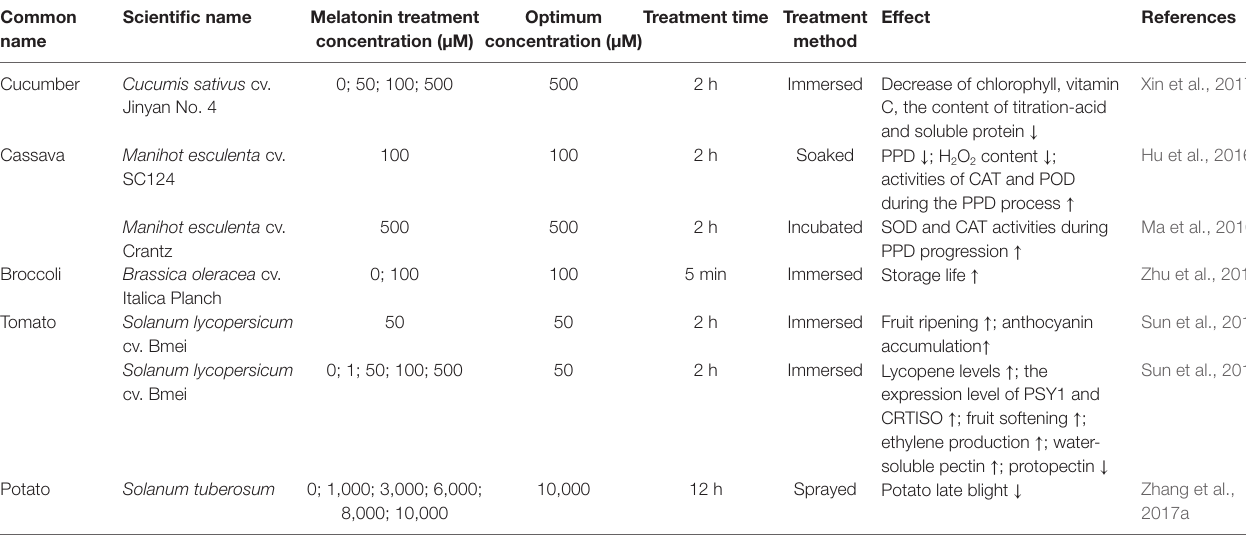
TABLe 4 | Effects of exogenous melatonin on the preservation and quality of post-harvest